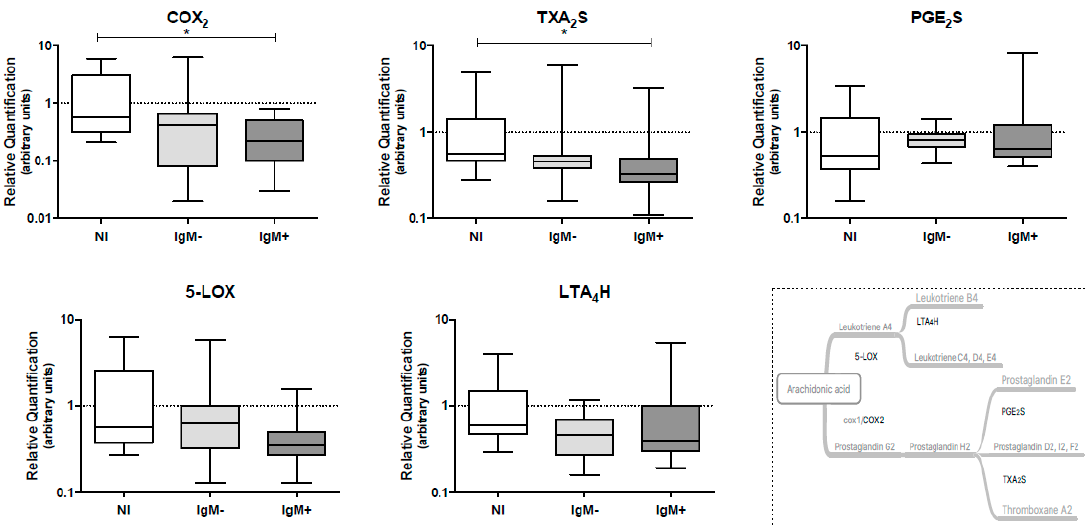
Figure 3. Quantification of mRNA levels coding for the eicosanoid-forming enzymes COX 2 , TXA 2 S, PGE 2 S, 5-LOX and LTA 4 H in peripheral blood leukocytes from dengue patients. The quantification of eicosanoid-forming enzymes was performed by RT-qPCR, using TaqMan ® gene expression assays and human β -actin TaqMan ® assay used to normalize the gene expression. Data represent the median, quartiles and extreme values. NI, Non-infected individuals ( n = 12); IgM − , DENV-infected individuals showing the absence of IgM in plasma ( n = 12); IgM + , DENV-infected individuals showing the presence of IgM in plasma ( n = 15). (*) p < 0.05. All analyses were determined by the Kruskal– Wallis/Dunn’s method.